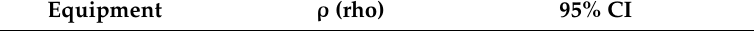
Table 4. Willow Springs correlation test results for site pollutant readings.